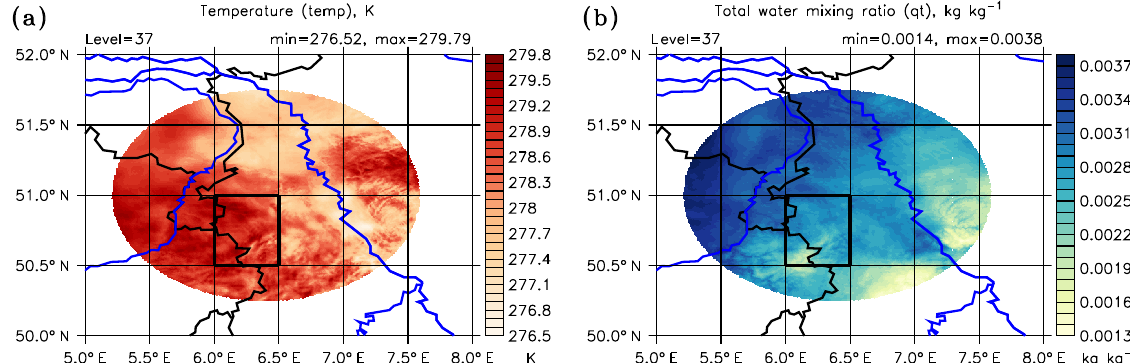
Figure 1. Snapshot on 24 April 2013, 01:00:00UTC simulation time on model level 37 (approx. 1800m) of the 3-D ICON model output over parts of the Netherlands, Belgium, and western Germany (a) temperature, (b) total water mixing ratio. Overlaid is the user-defined regular coarse grid (0.5 ◦ × 0.5 ◦ ) used to perform the online diagnostics in this study. For orientation note the country borders in black and larger rivers in